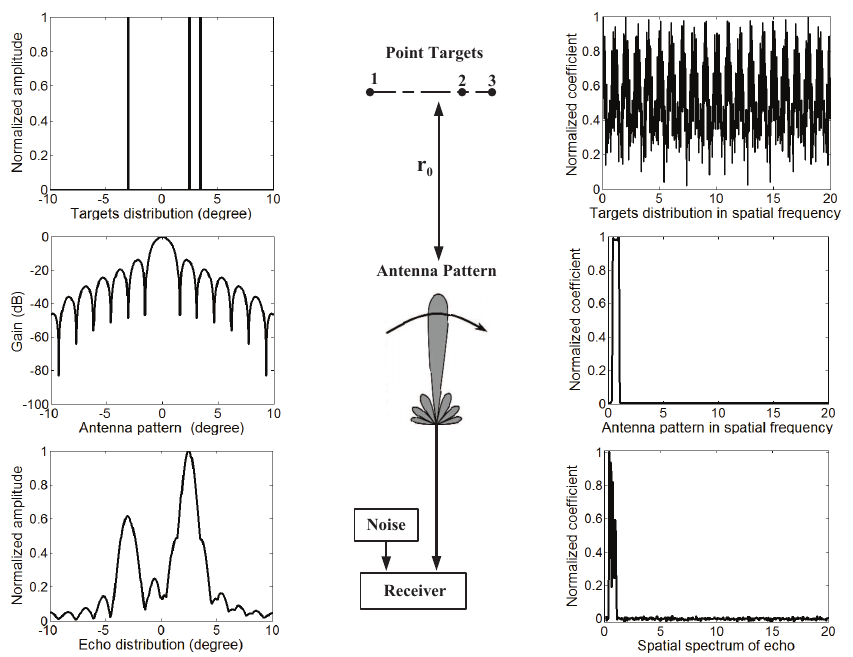
Figure 1. Illustration of signal model for scanning radar